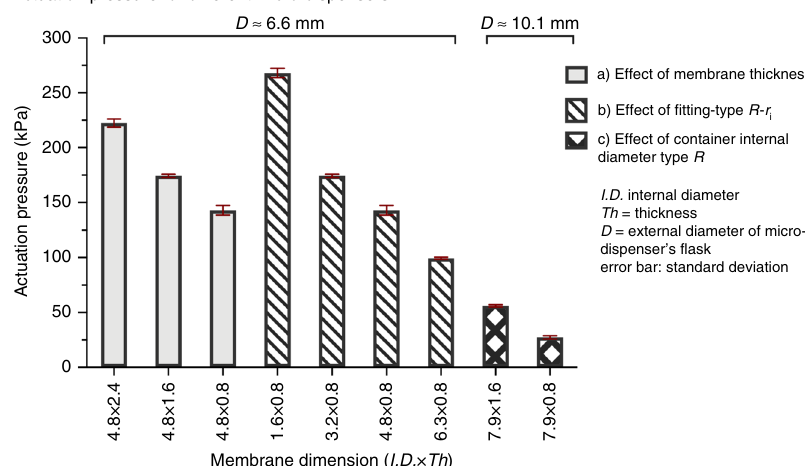
Fig. 1 Characterization of actuation pressure for a micro-dispenser (membrane made of latex) set. a A dispenser of outer diameter D = 6.6 mm is sheathed in membranes of fi xed internal diameter and different thickness, b a dispenser of outer diameter D = 6.6 mm is sheathed in membranes of fi xed thickness and different internal diameters, and c a dispenser of outer diameter D = 10.1 mm is sheathed in membranes of fi xed internal diameter and different thickness